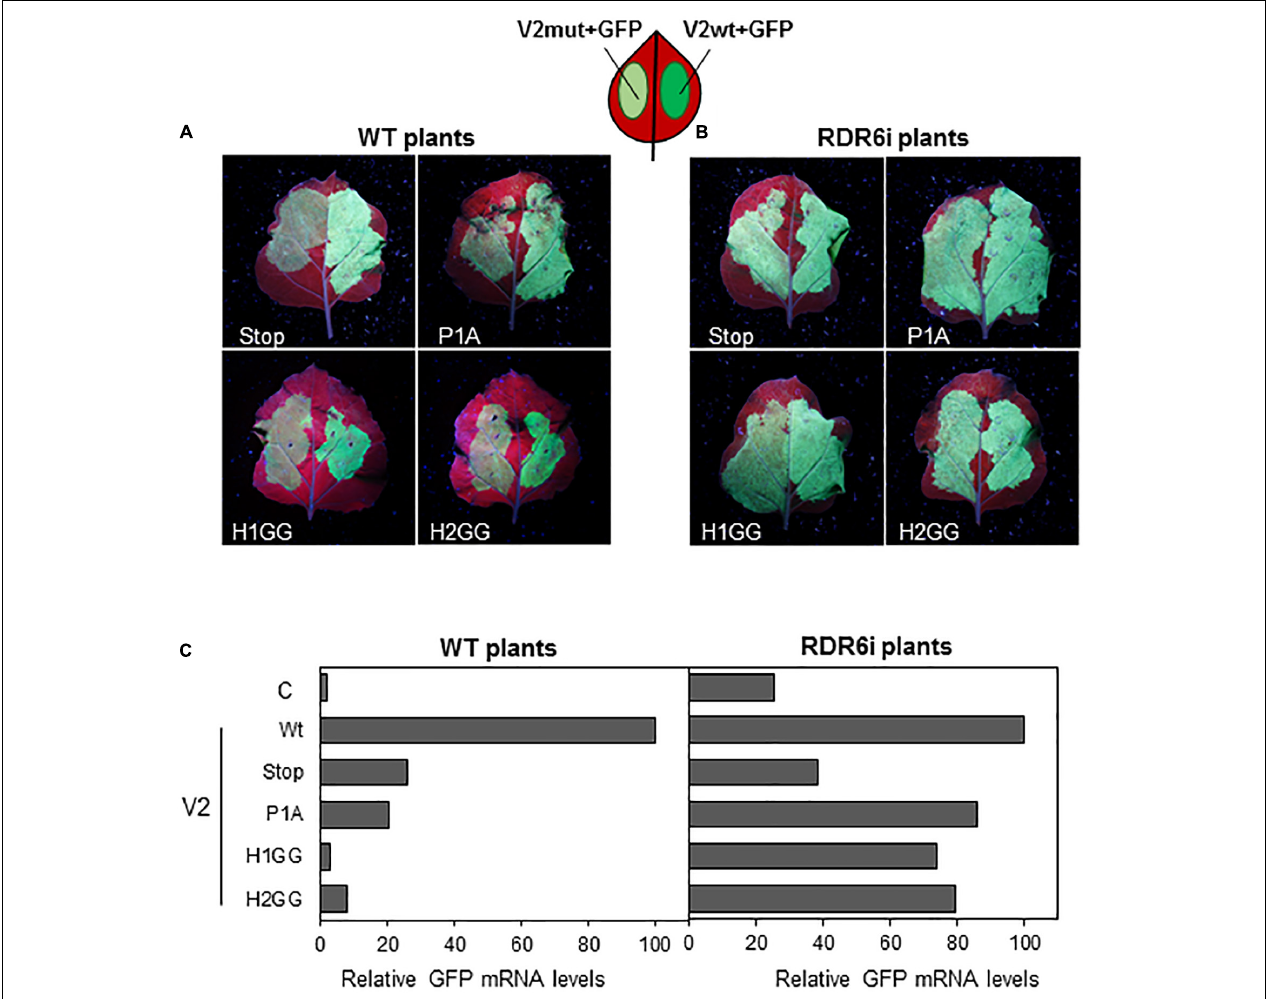
FIGURE 3 | Local PTGS suppression activity of V2 mutants in wild-type (WT) and RDR6i N. benthamiana plants. Leaves from WT (A) and RDR6i (B) N. benthamiana plants infiltrated with a mixture of two A. tumefaciens cultures containing GFP and the desired V2 construct, were photographed under UV light at 5 dpi. Wild-type V2 protein (wt) was used as a positive control. (C) Relative GFP mRNA levels in infiltrated tissues at 5 dpi. GFP levels were normalized to EF1 and are presented as the relative amount of transcripts compared with the amount found in wild-type V2 (wt) samples (set to 100%). Bars represent mean values from a pool of 2–3 leaves obtained from 4 plants for each combination. Similar results were obtained in two independent